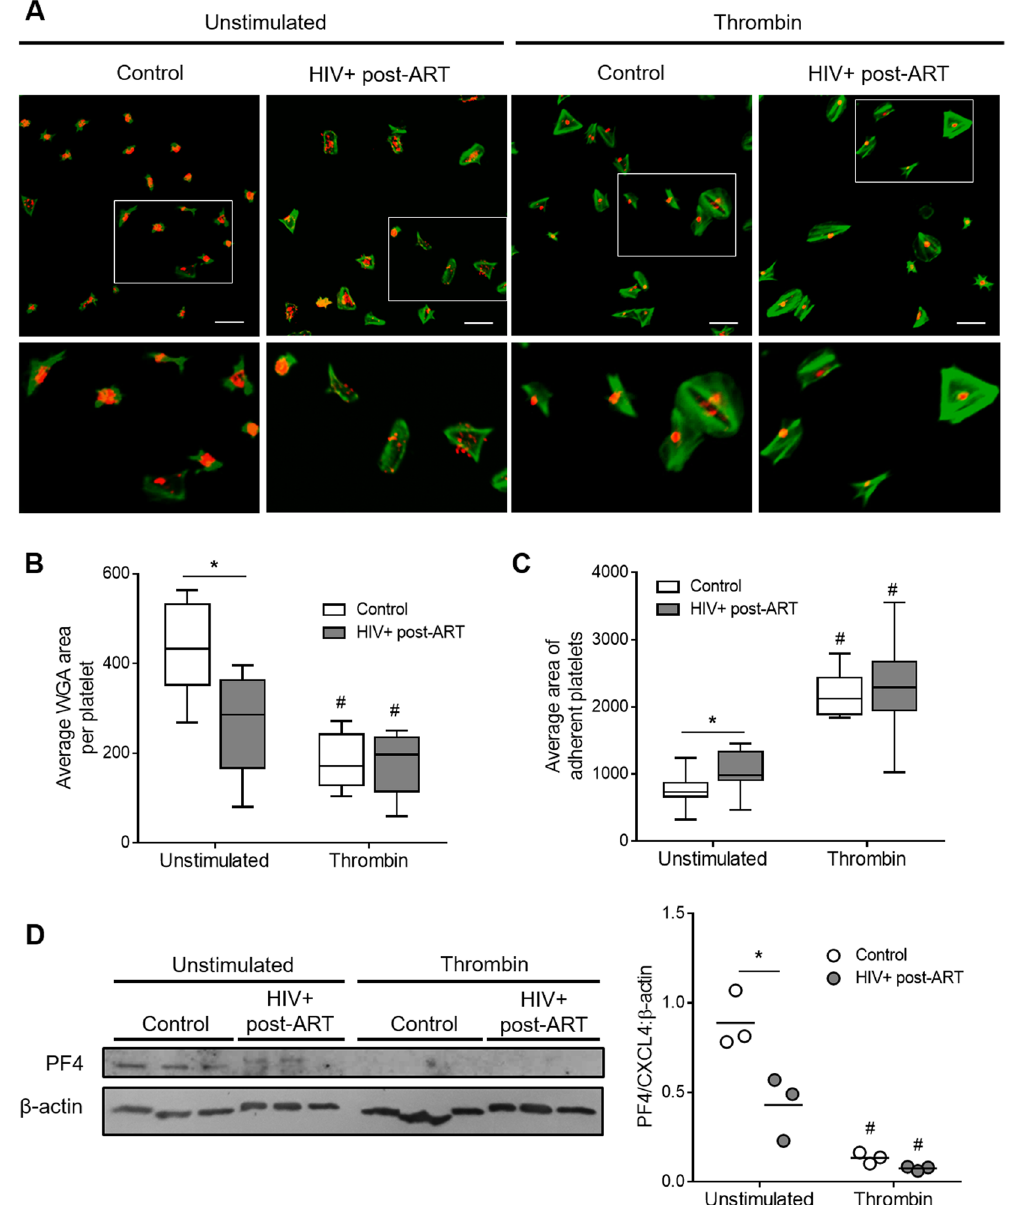
Figure 4. Thrombin-induced platelet spreading and degranulation in HIV-infected individuals under stable cART and healthy volunteers. ( A ) Platelets from healthy subjects (control) or HIV-infected individuals under viral control (HIV-1 viral load < 50 copies/ml in the peripheral blood) were stimulated with thrombin (0,0 or 0,4 U/mL), adhered to fibrinogen-coated surfaces and labeled with phalloidin (green) and wheat germ agglutinin (WGA – red) as described in methods. ( B ) Average area of WGA labeling per platelet number in each field for unstimulated or thrombin-stimulated platelets from control or HIV-1-infected subjects. ( C ) Average area of spontaneous or thrombin-induced platelet spreading on fibrinogen-coated surfaces in each condition. Images are representative of eight HIV-infected individuals and healthy volunteers analyzed in parallel. Scale bars represent 10 µ m. The horizontal lines on the box plots represent the median, boxes limits indicate interquartile ranges and the whiskers indicate 5–95 percentile. ( D ) Western blot analysis for PF4/CXCL4 and β -actin in platelets from three healthy volunteers and three HIV-infected subjects under stable cART that were kept unstimulated or stimulated with 0.4 U/mL of thrombin. Dots represent the band intensity of PF4 corrected by β -actin expression in each experimental condition. Horizontal lines represent mean. The asterisk ( * ) signify p < 0.05 compared to healthy volunteers and # means p < 0.05 compared to unstimulated